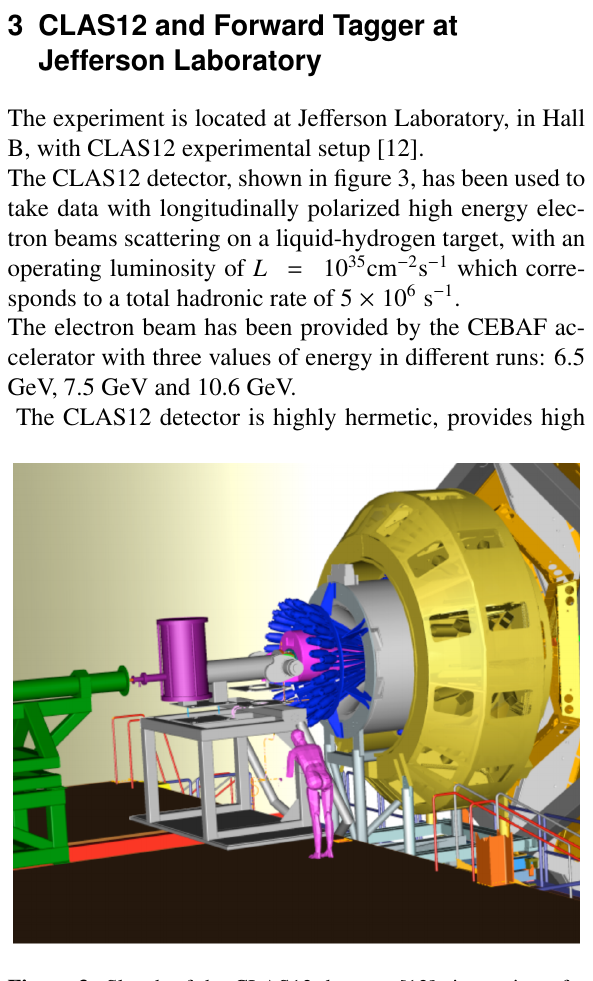
Figure 3. Sketch of the CLAS12 detector [12]: it consists of a central detector (CD) equipped with a superconducting solenoid and a forward detector (FD) equipped with a torus magnet, to cover polar angular ranges from 35 ◦ to 125 ◦ and from 5 ◦ to 35 ◦ ,